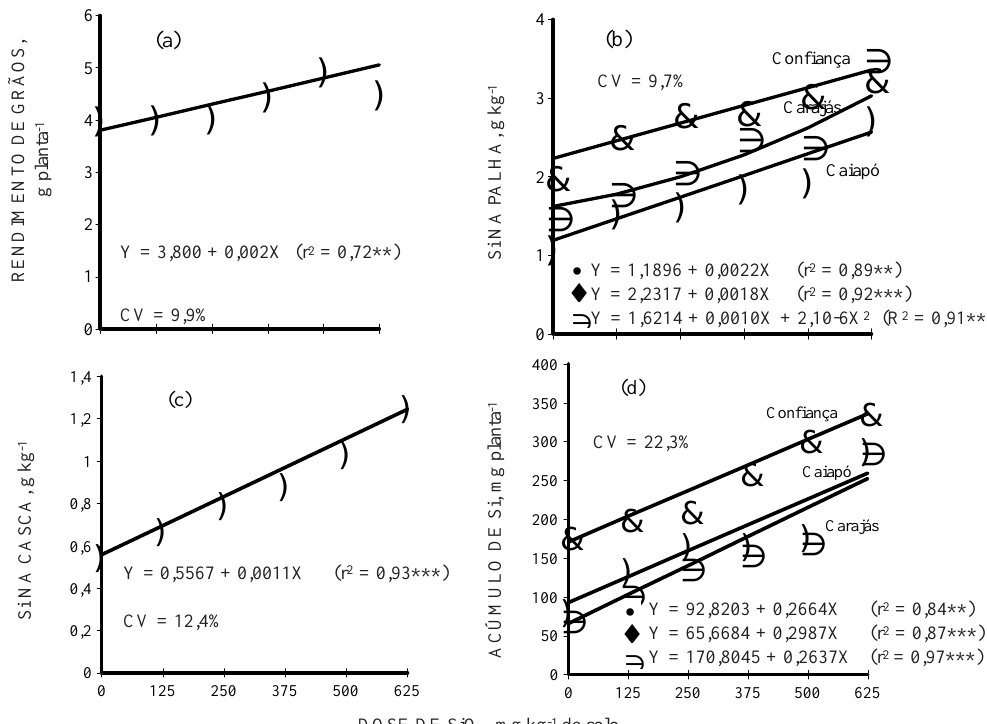
Figura 1. Características de planta influenciadas pela aplicação de doses de SiO Vermelho-Escuro distrófico (a) rendimento de grãos, (b) teor de Si na palha, (c) teor de Si na casca e